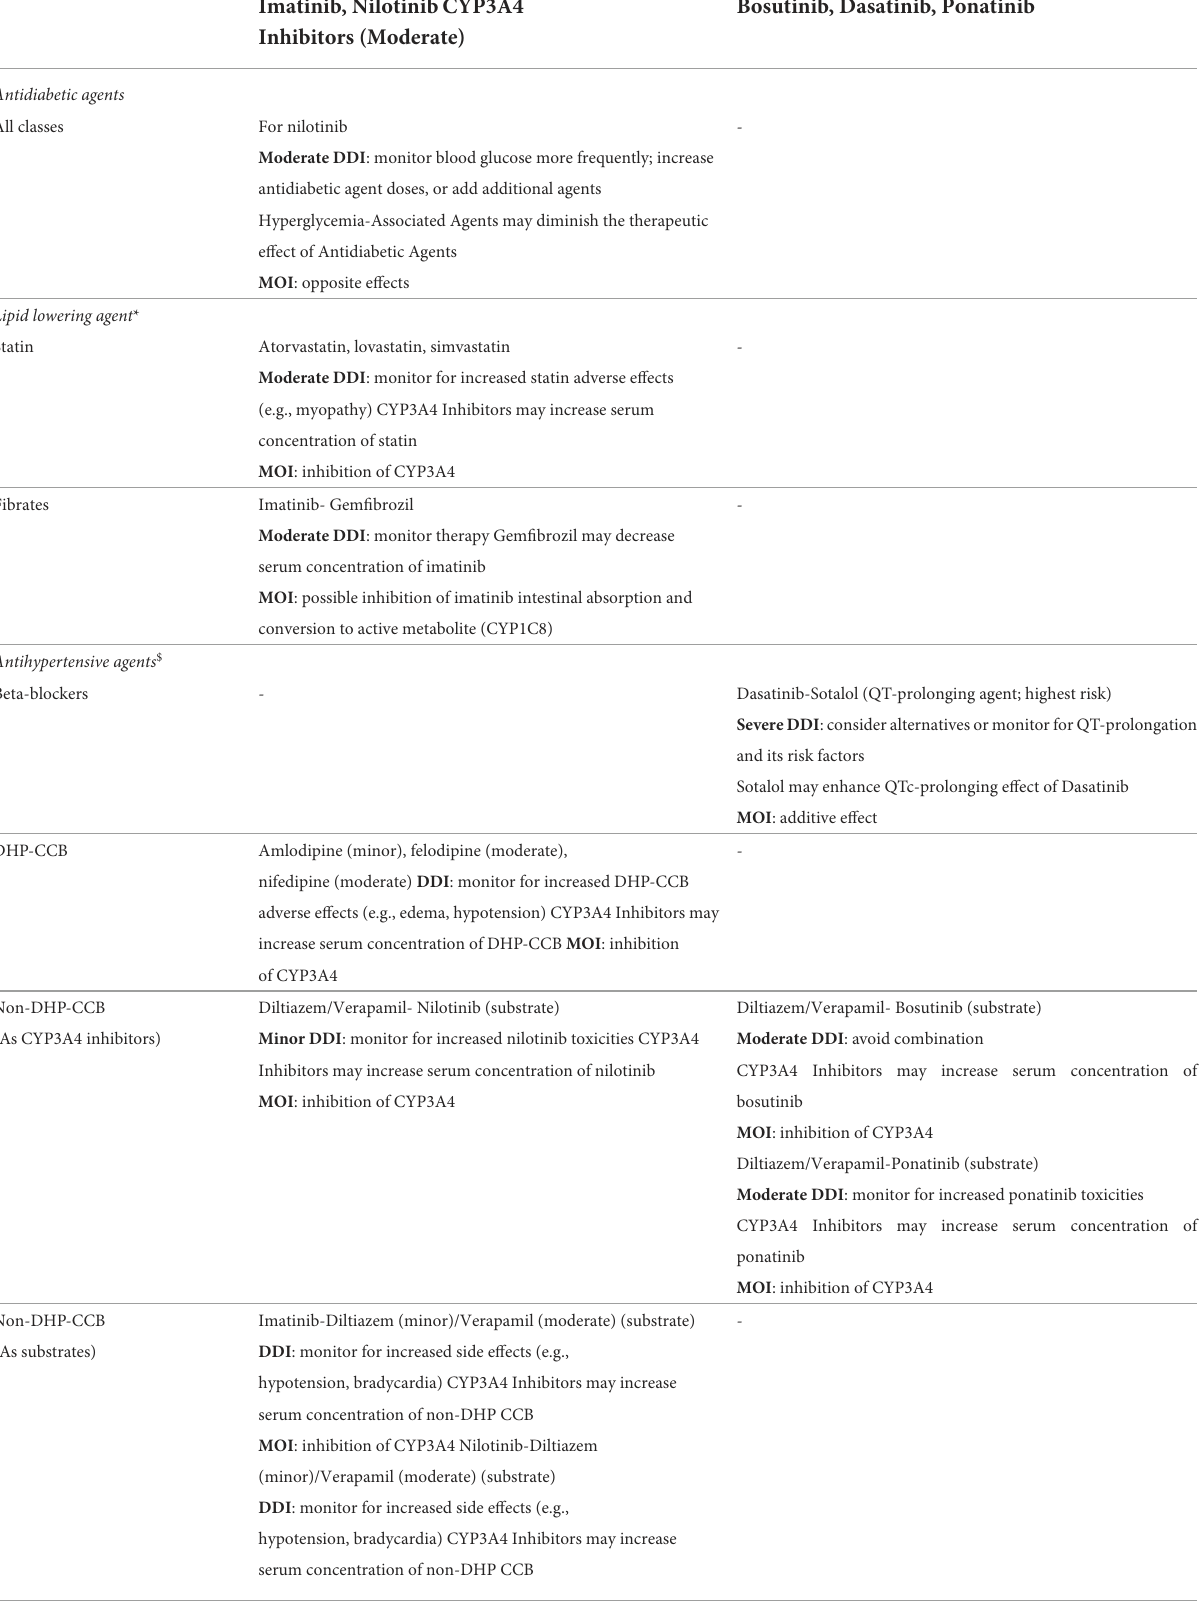
TABLE 5 Drug-drug interactions between TKI and therapy of common conditions. Imatinib, Nilotinib CYP3A4 Inhibitors